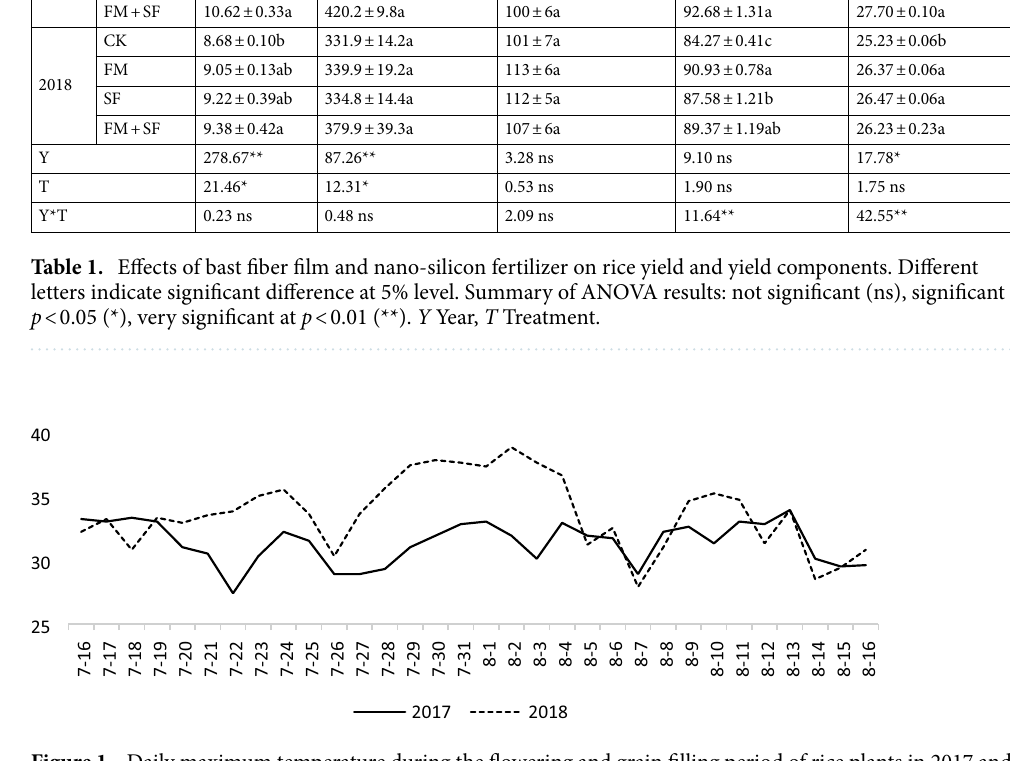
Figure 1. Daily maximum temperature during the flowering and grain filling period of rice plants in 2017 and